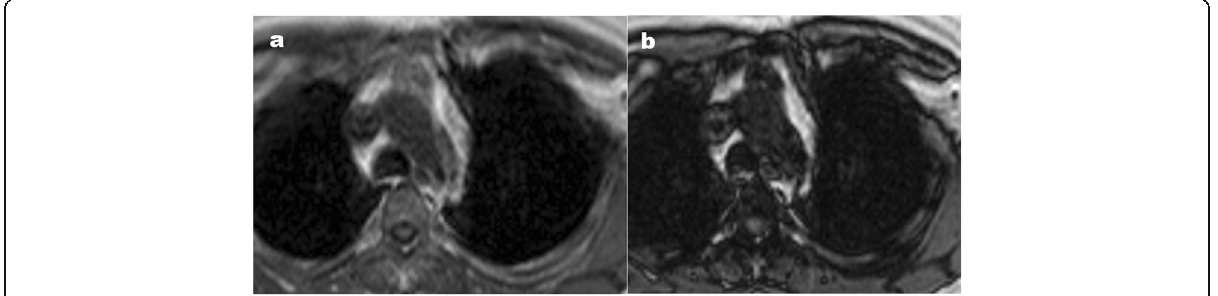
Fig. 3 Axial MRI chest in a 28-year-old male revealed anterior mediastinal mass that is iso-intense to muscle on in-phase images ( a ) and b demonstrating a decrease in signal intensity on opposed-phase images indicating microscopic fat, CSR = 0.4. These findings are compatible with thymic hyperplasia. MRI diagnosis and histopathological confirmation revealed “ thymic hyperplasia ”